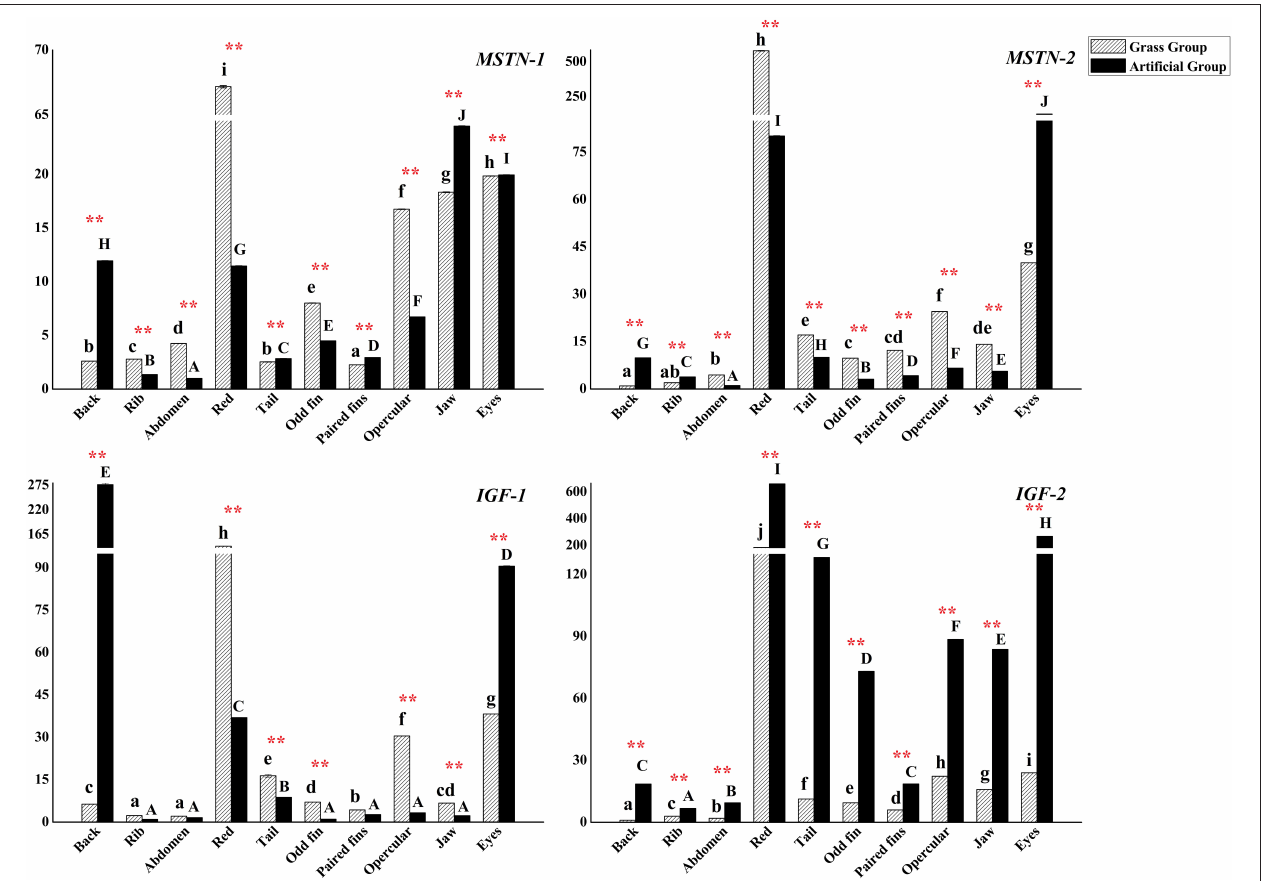
FIGURE 6 | The expression levels of C. idellus MSTN - 1 , MSTN - 2 , IGF - 1, and IGF - 2 in different muscle tissues . The expression levels of C. idellus MSTN - 1 , MSTN - 2 , IGF - 1, and IGF - 2 in back, rib, abdomen, red, tail, odd fin, paired fins, opercular, jaw, and eyes positions of the two culture model C. idellus . The expressions of genes in grass feed group represented in dense slash filling, which in artificial feed represented in black filling. The β -actin was used as an internal control to calibrate the cDNA template for all the samples. Vertical bars represent the mean SE. Different letters mean significantly different ( P < 0.05) in the same model, lowercase letters ± used in grass feed group, capital letters used in artificial feed group. Meanwhile, the star bars also indicate the significance between the two culture models in red color, * means significant ( P < 0.05), ** means greatly significant ( P <